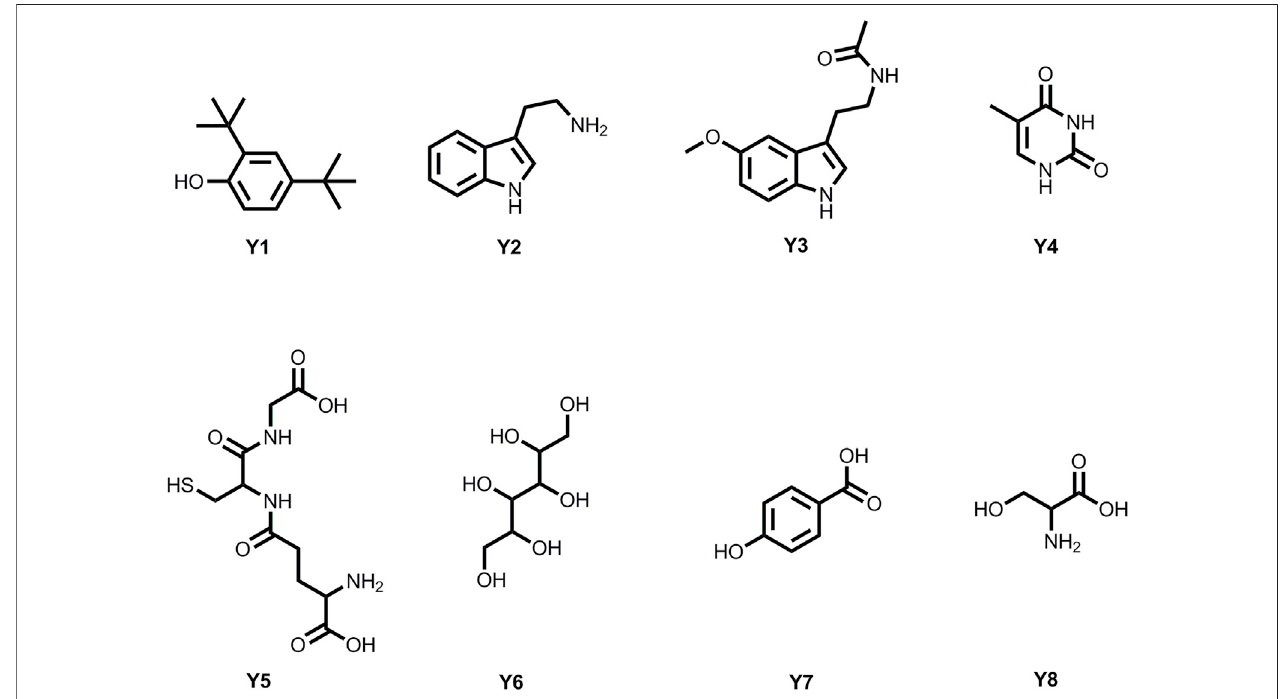
FIGURE 3 | Chemical structures of eight